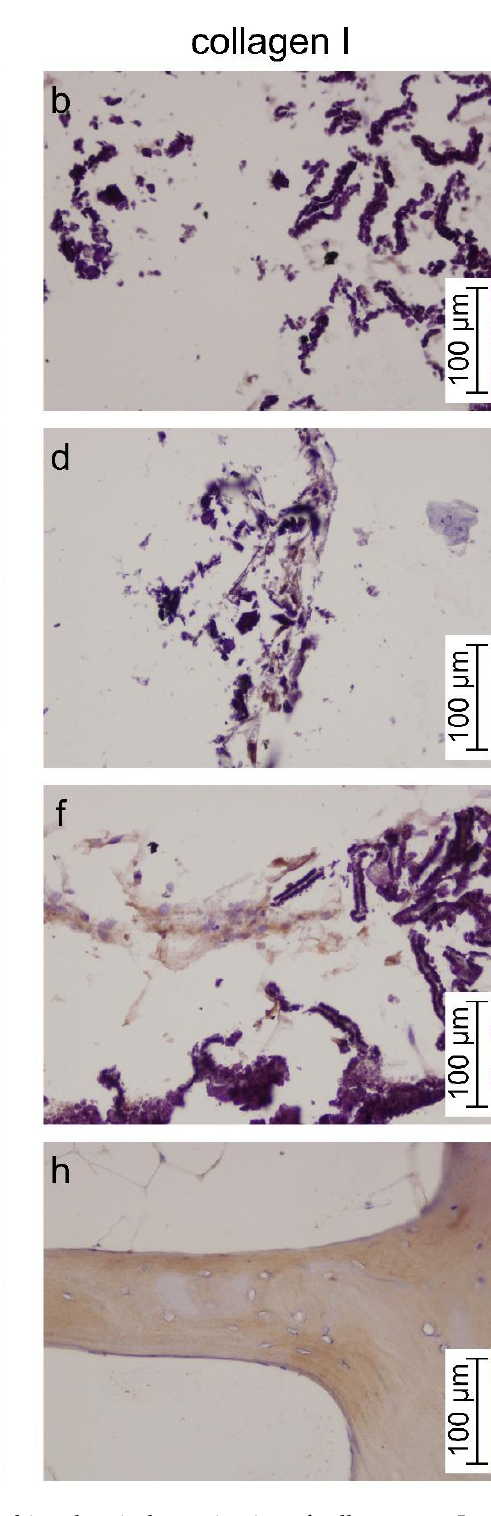
Figure 8. Histological staining (hematoxylin/eosin) and immunohistochemical examination of collagen type I on 1-Mg- CaP/PCL and 1-Mg-1-Sr-CaP/PCL scaffolds after 21 days of osteogenic induction. As negative control (-ctrl) sections were processed for each sample in the absence of the suitable antibody ( a , b ). Human bone was used as a sample for the positive control ( g , h ). In figure ( c , e , g ) nuclei are stained blue-purple, whereas the cytoplasm and extracellular matrix have varying degrees of pink staining. Brown color indicates positive staining of collagen ( b , d , f ). Representative images are shown at 20× magnification and the scale bars represent 100 μm.